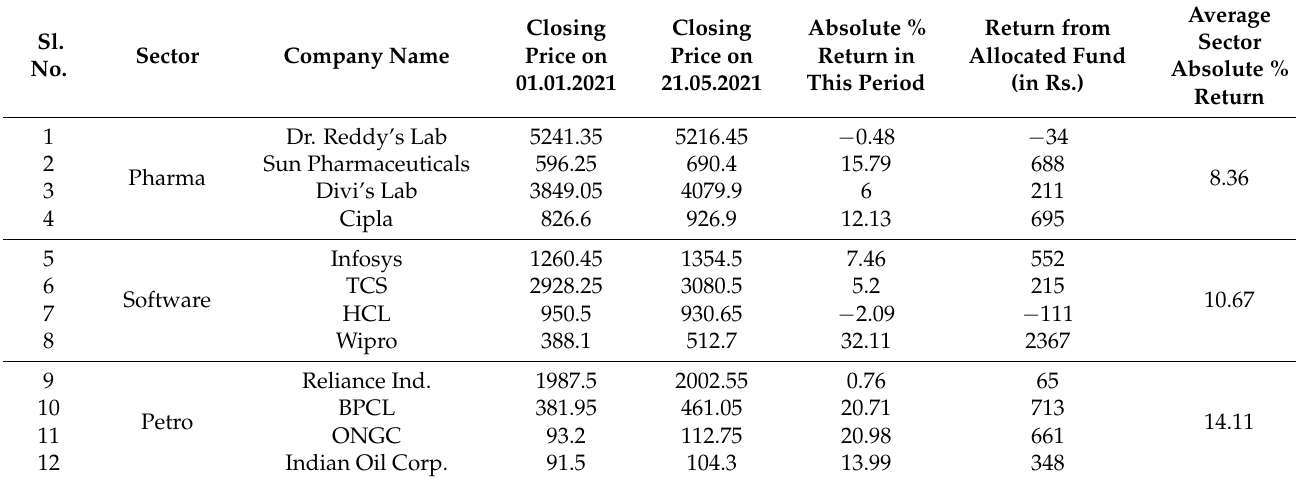
Table 5. Absolute % return from 1 January to 21 May